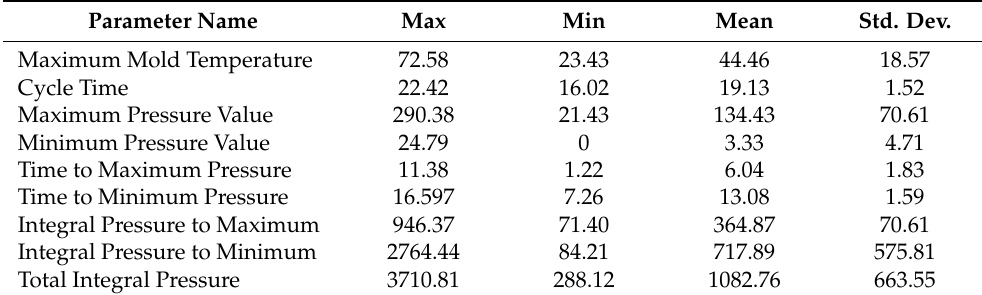
Table 4. The parameter of the injection molding